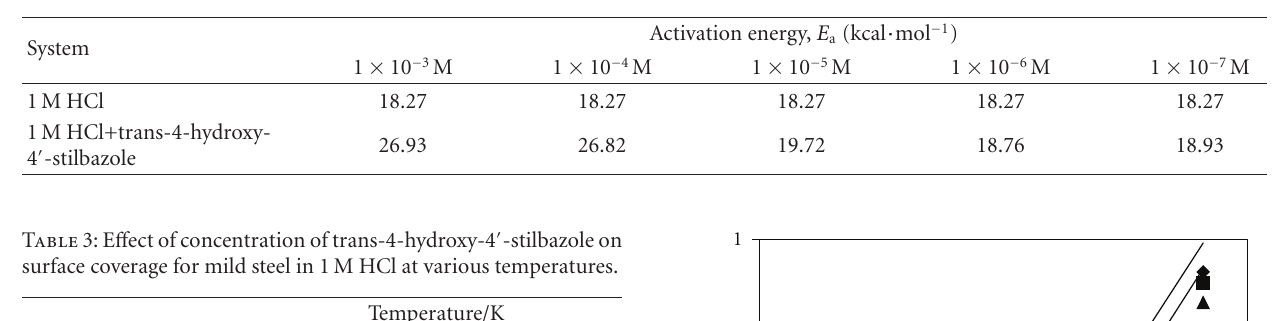
Table 2: The activation energy ( E a ) for the corrosion of mild steel in 1M HCl with and without trans-4-hydroxy-4 (cid:2) -stilbazole inhibitor at various concentrations.